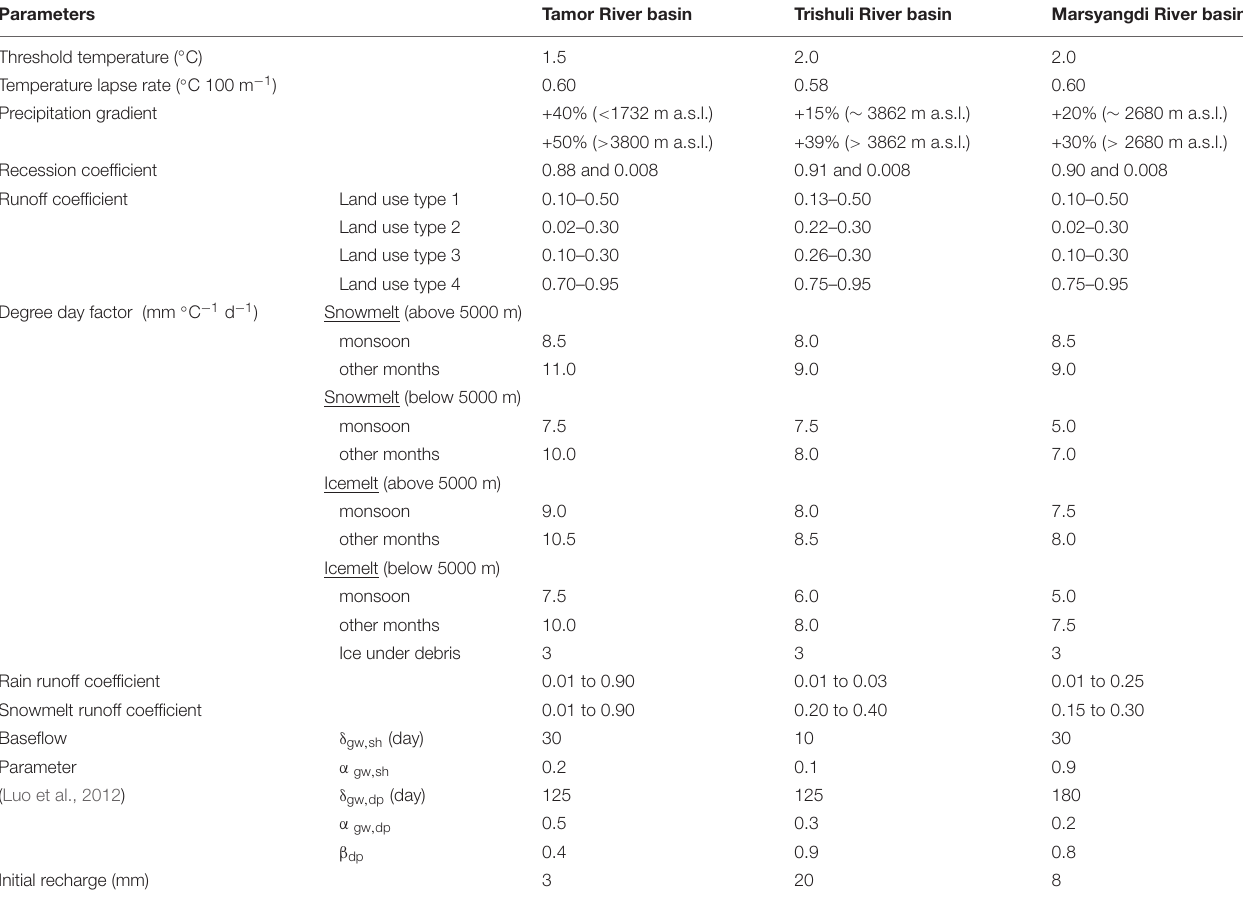
TABLE 3 | Parameter and coefficients used for calibrating the model in Tamor, Trishuli, and Marsyangdi River basins.